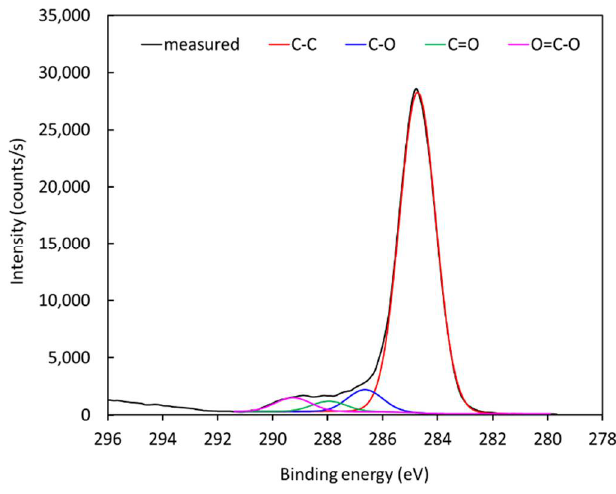
Figure 11. High-resolution C1s spectrum for a treated sample.